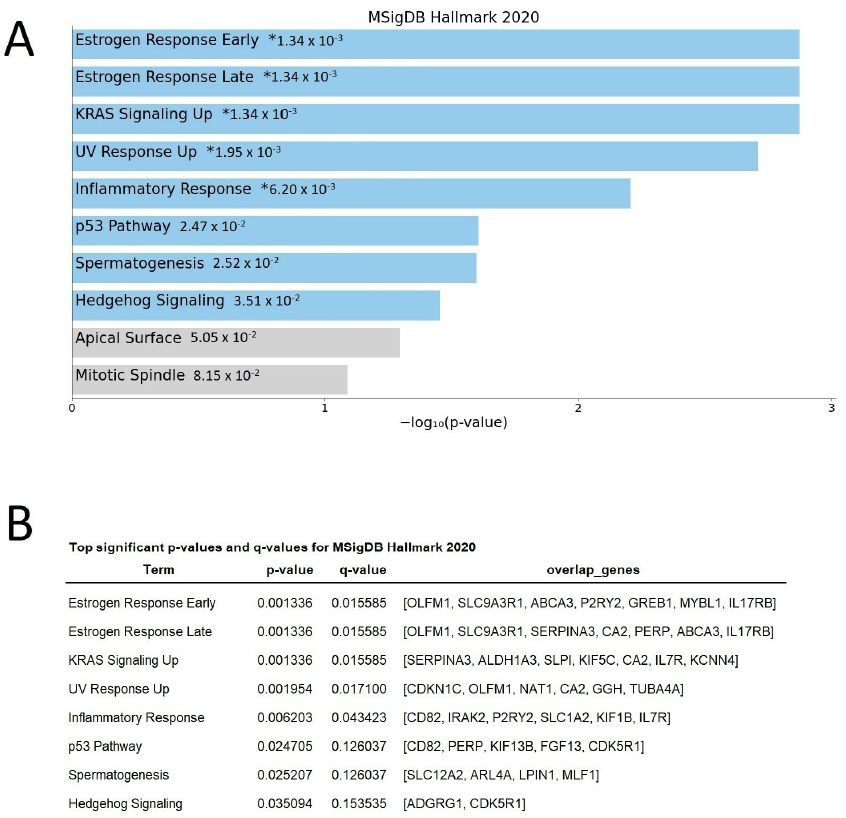
Figure 1. MSigDB Hallmark 2020 analysis. ( A ) Bar chart of top enriched terms from the MSigDB Hallmark 2020 gene set library. The top 10 enriched terms for the input gene set are displayed based on the − log10 ( p ‐ value), with the actual p ‐ value shown next to each term. The term at the top has the most significant overlap with the input query gene set. The asterisk (*) indicates a significant adjusted p ‐ value (<0.05). The adjusted p ‐ value is computed using Benjamini ‐ Hochberg method for correction for multiple hypothesis testing ( B ) Table displaying the names, p ‐ values, and q ‐ values of significant terms and the genes from the input that were found to be associated with that term. The q ‐ value is an adjusted p ‐ value calculated using the Benjamini ‐ Hochberg method of correction for multiple hypothesis testing. Only the top significant results are displayed.